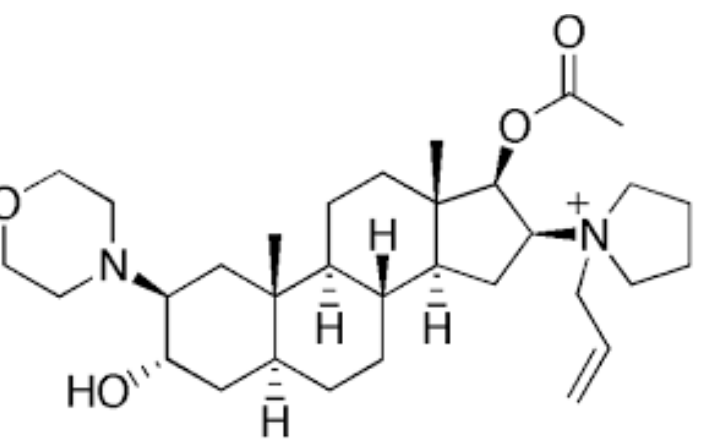
Figure 1. Chemical structure of rocuronium.